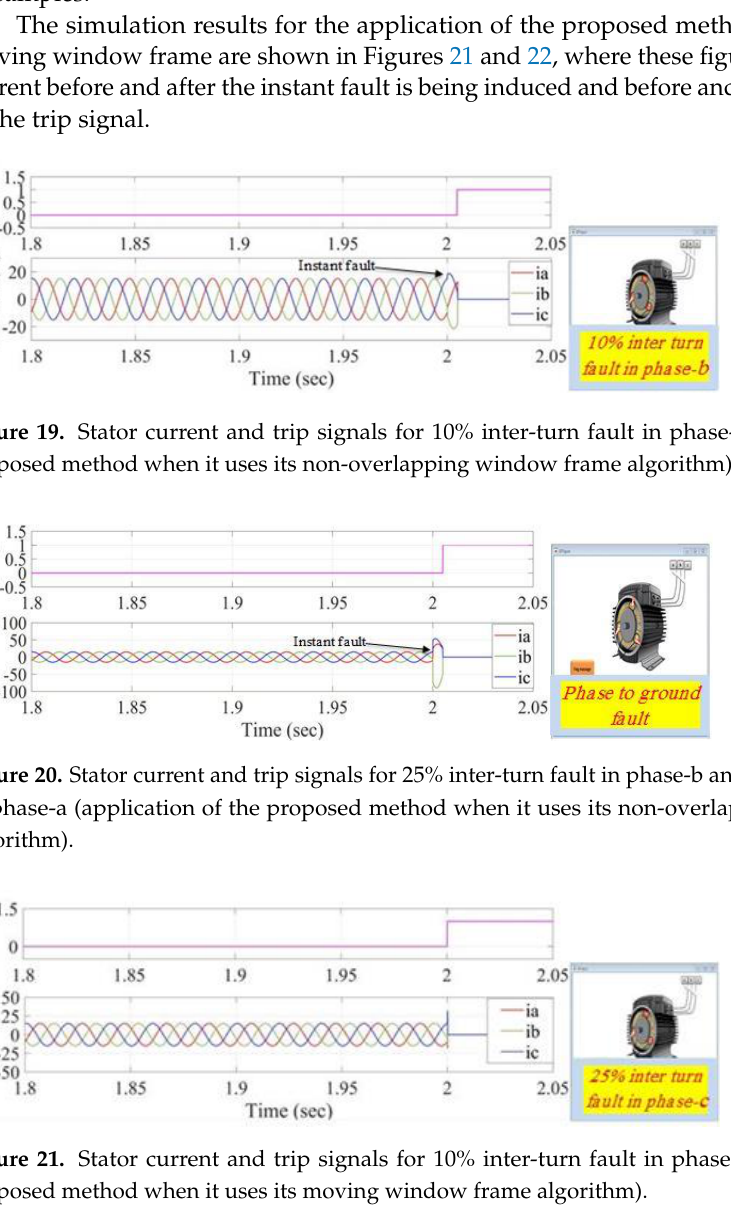
Figure 21. Stator current and trip signals for 10% inter-turn fault in phase-c (application of the proposed method when it uses its moving window frame algorithm).